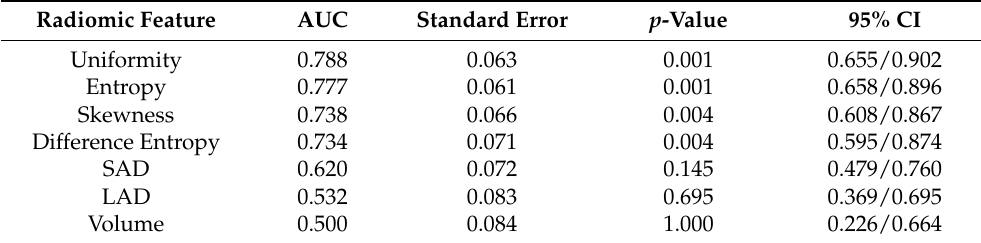
Table 2. Parameters evaluated for predictive performance, including morphologic measurements and radiomic